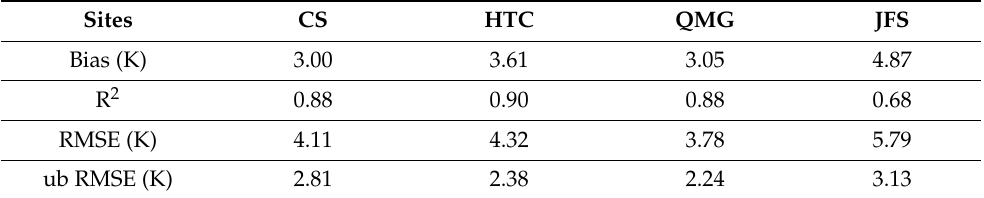
Table 3. Bias, R 2 , RMSE and ub RMSE of difference between the reconstructed LSTs and in situ for four